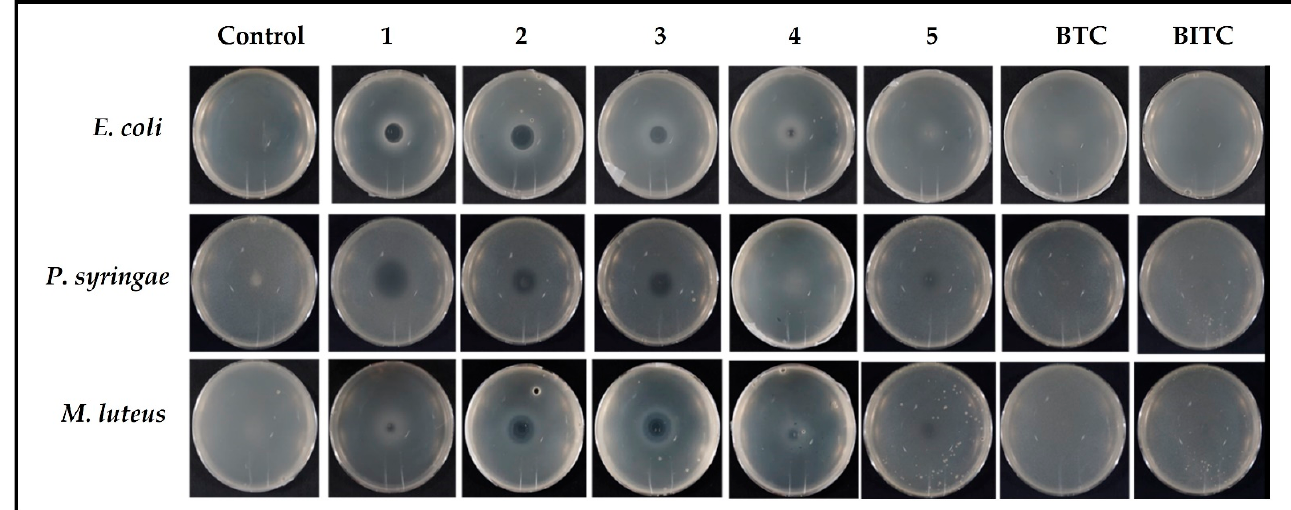
Figure 3. Selenocyanates provide antimicrobial activity against E. coli , P. syringae , and M. luteus via the gas phase, whilst thiocyanates (BTC and BITC) remain totally ineffective against the bacteria